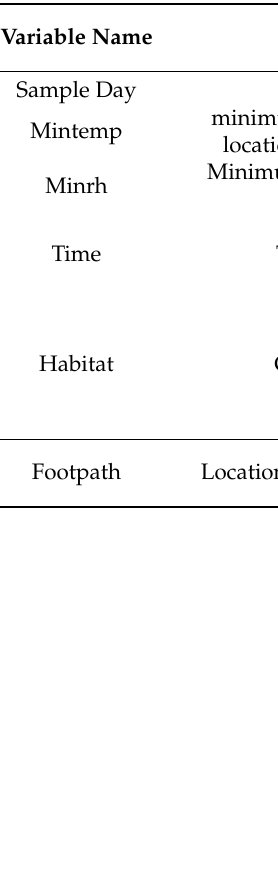
Table 1. Explanatory variables predicting each of gastropod presence, gastropod relative abundance, dog presence and dog relative abundance in Generalized Linear Models (GLMs) at seven sites in Brighton and Hove and surrounding areas in England,